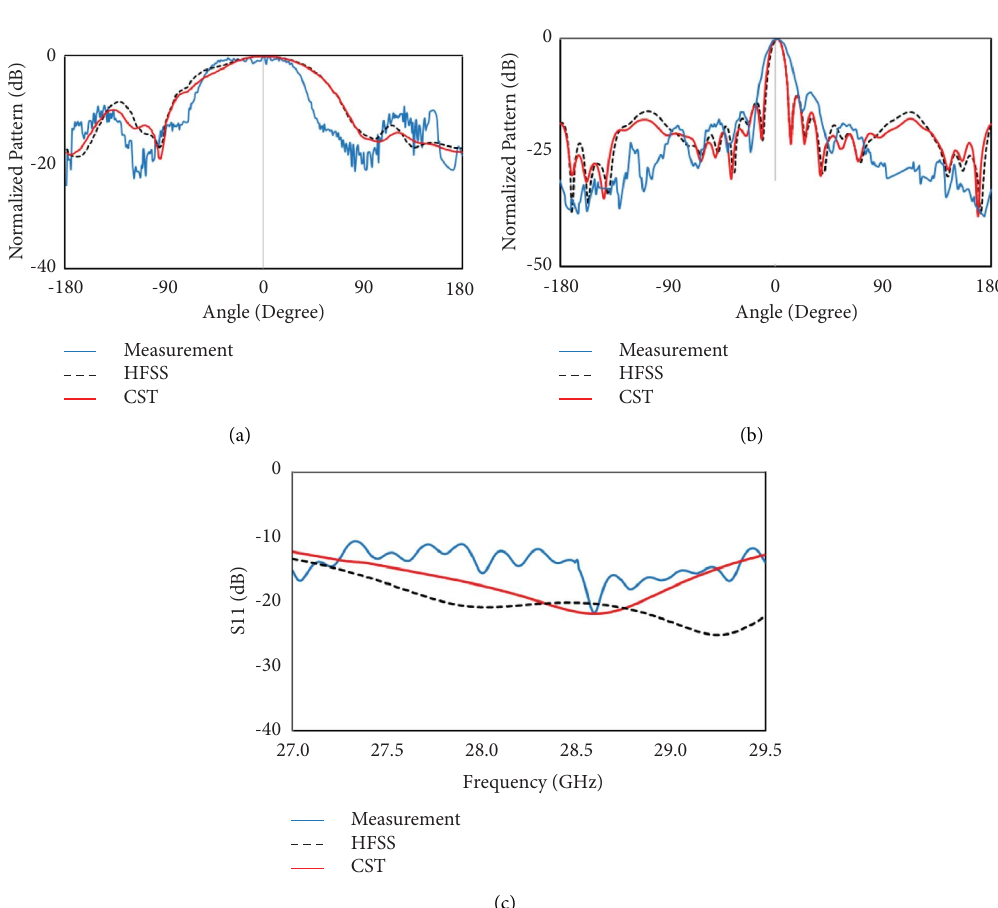
Figure 5: (a) Normalized H pattern, (b) Normalized E -pattern, and (c) S